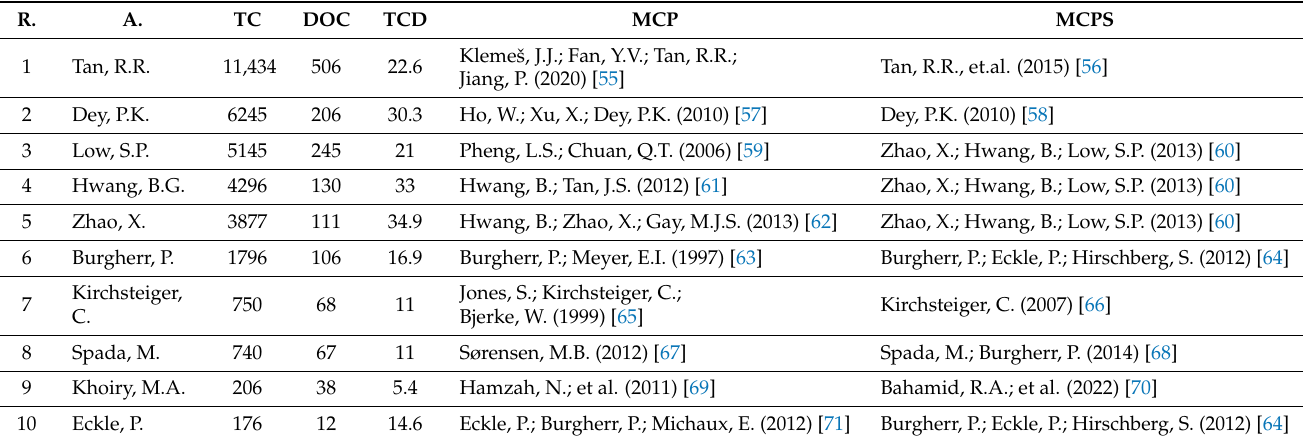
Table 3. List of the highly cited